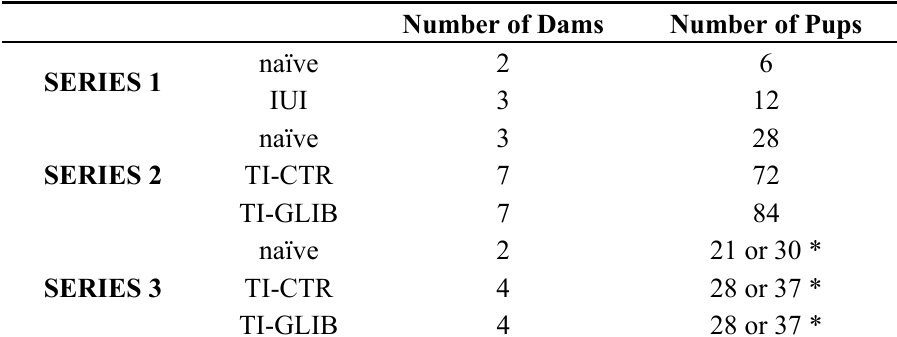
Table 1. Number of rats in 3 experimental